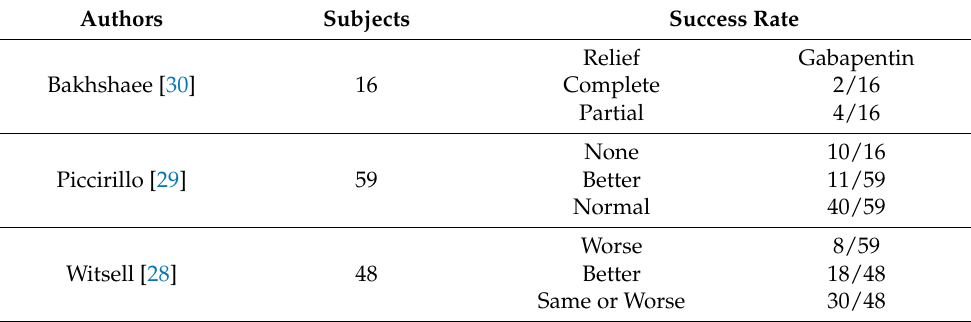
Table 5. Summary of studies that used gabapentin to treat